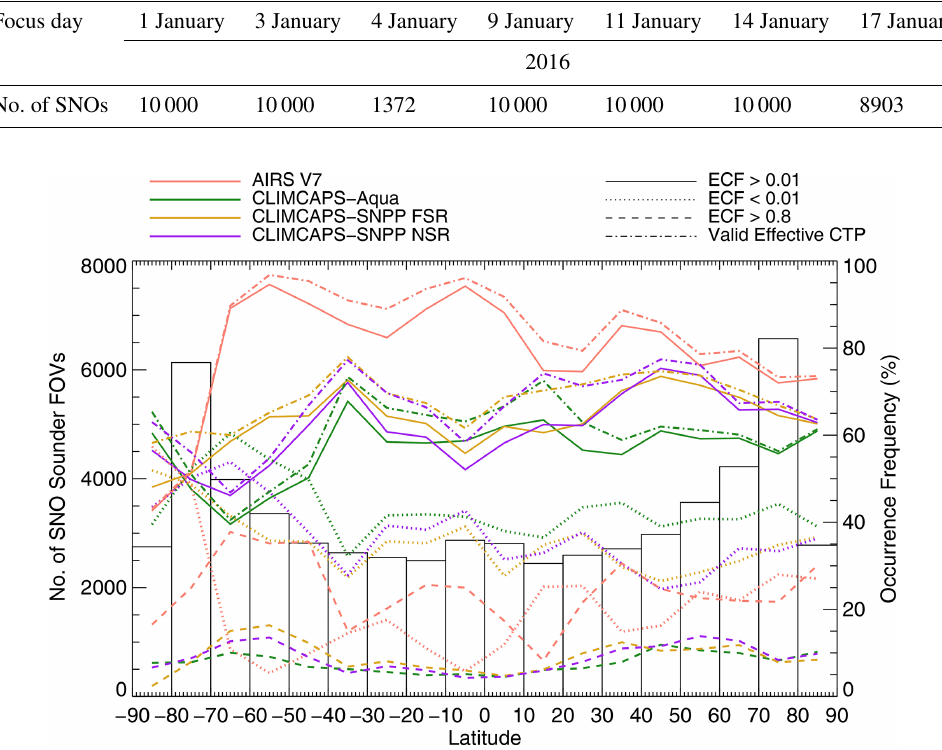
Figure 1. The latitudinal distribution of the SNO pairs for Aqua AIRS and SNPP CrIS (black bars) and the occurrence frequencies of various sounder retrieved cloud parameters (right y axis, %) for four composites that satisfy the following four conditions, respectively: ECF > 0 . 01 (solid lines, general cloudy condition), ECF ≤ 0 . 01 (dotted lines, clear or very thin clouds), ECF > 0 . 8 (dashed lines, overcast or very thick clouds), and cases with successful CTP retrievals (dash-dotted lines, QC for CTP is 0 or 1). Data from the 7 focus days are used (see Table 2) and binned by latitude of the sounder FOVs in 10 ◦ latitude bins. Four different sounder retrieval products are shown by colored lines: AIRS version 7 (AIRS V7, pink), CLIMCAPS-Aqua (green), CLIMCAPS-SNPP FSR (yellow), and CLIMCAPS-SNPP NSR (purple). Occurrence frequency is calculated as the percentage of AIRS or CrIS FOVs with successful cloud retrievals (quality control indicator is 0 or 1) satisfying the aforementioned four conditions to the total number of FOVs in each latitudinal